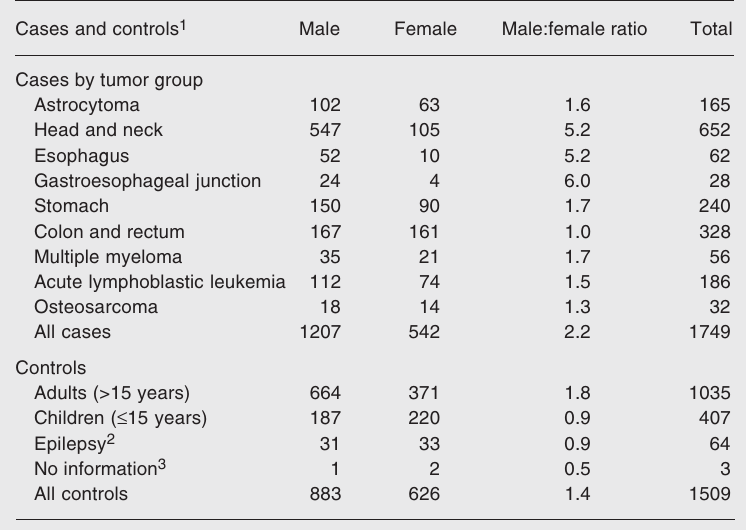
Table 1. Number of participants by tumor group and controls recruited from January 2001 to December 2004. Cases and controls